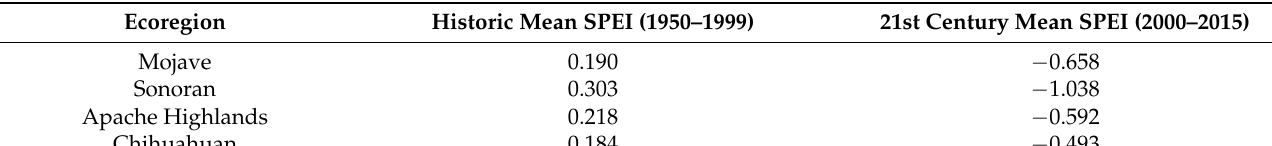
Figure 5. Time series of the spatial mean of monthly 12-month SPEI timescales for a period of 1950 January to 2015 De- cember significant at p ≤ 0.05 for the Mojave, Sonoran, Chihuahuan deserts, and Apache Highlands. The data is obtained from Global Drought Monitor [31] and breaks in lines represent missing data.